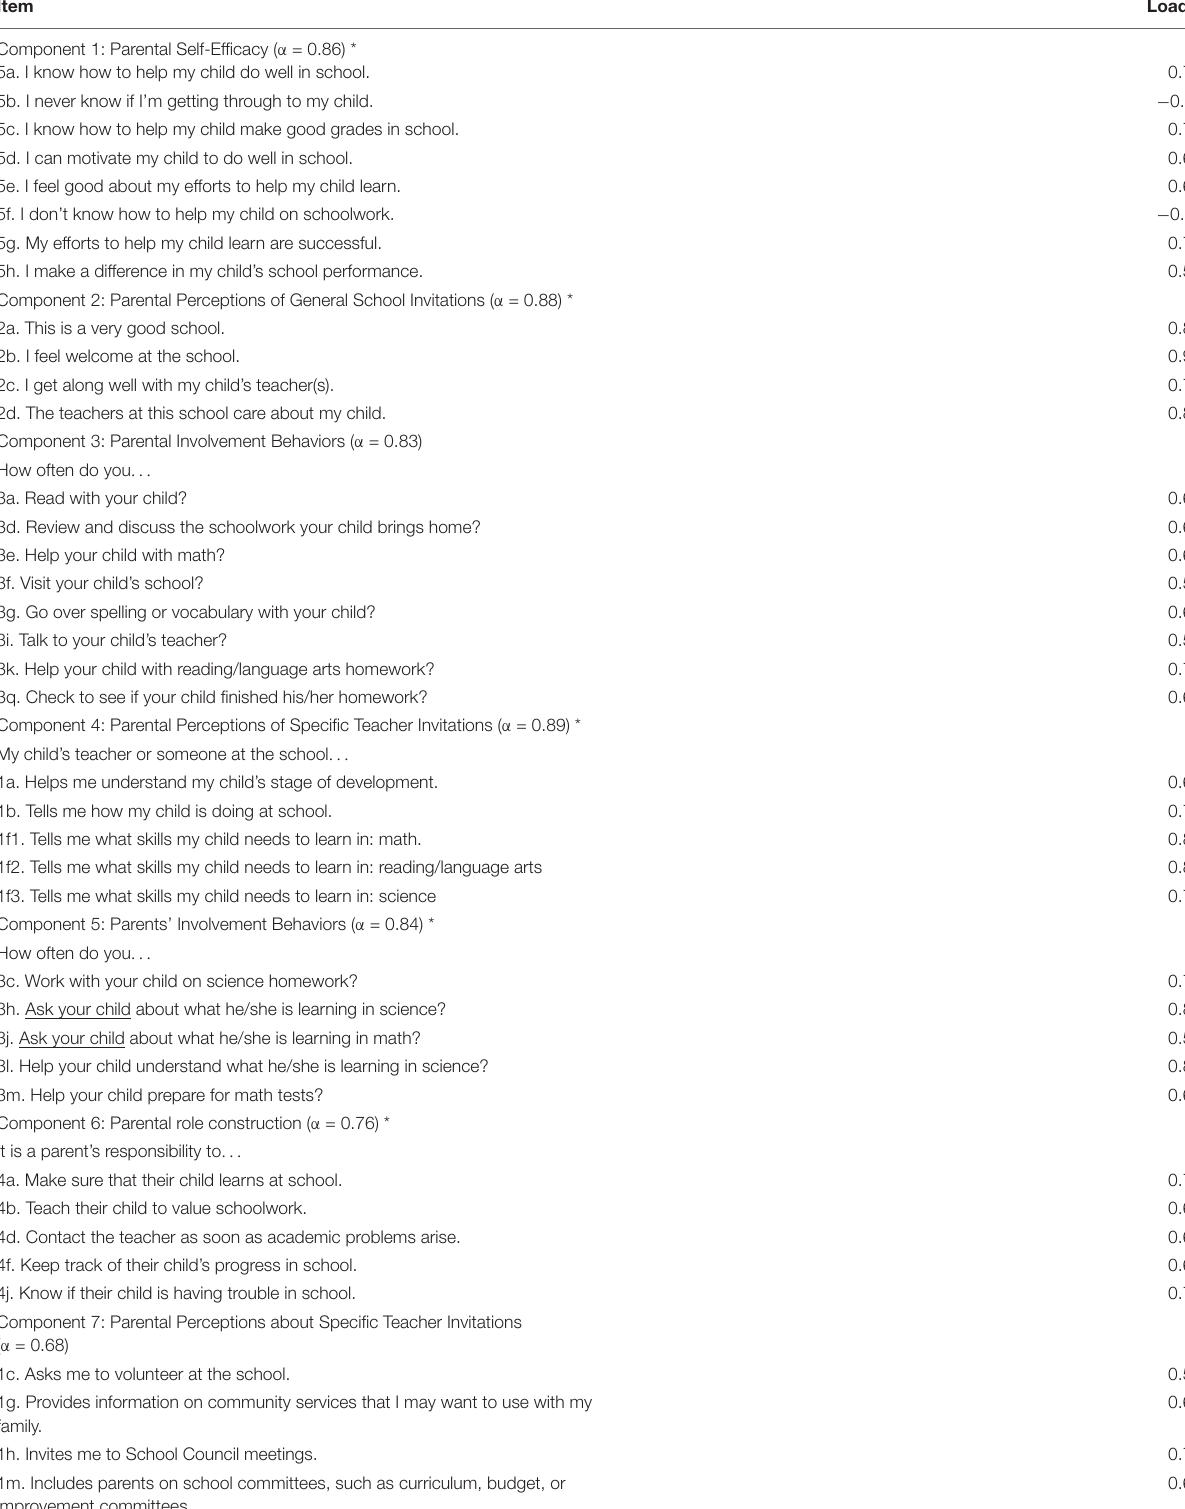
TABLE 2 | Direct oblimin rotation loadings of parental involvement survey items (all seven components shown). Item